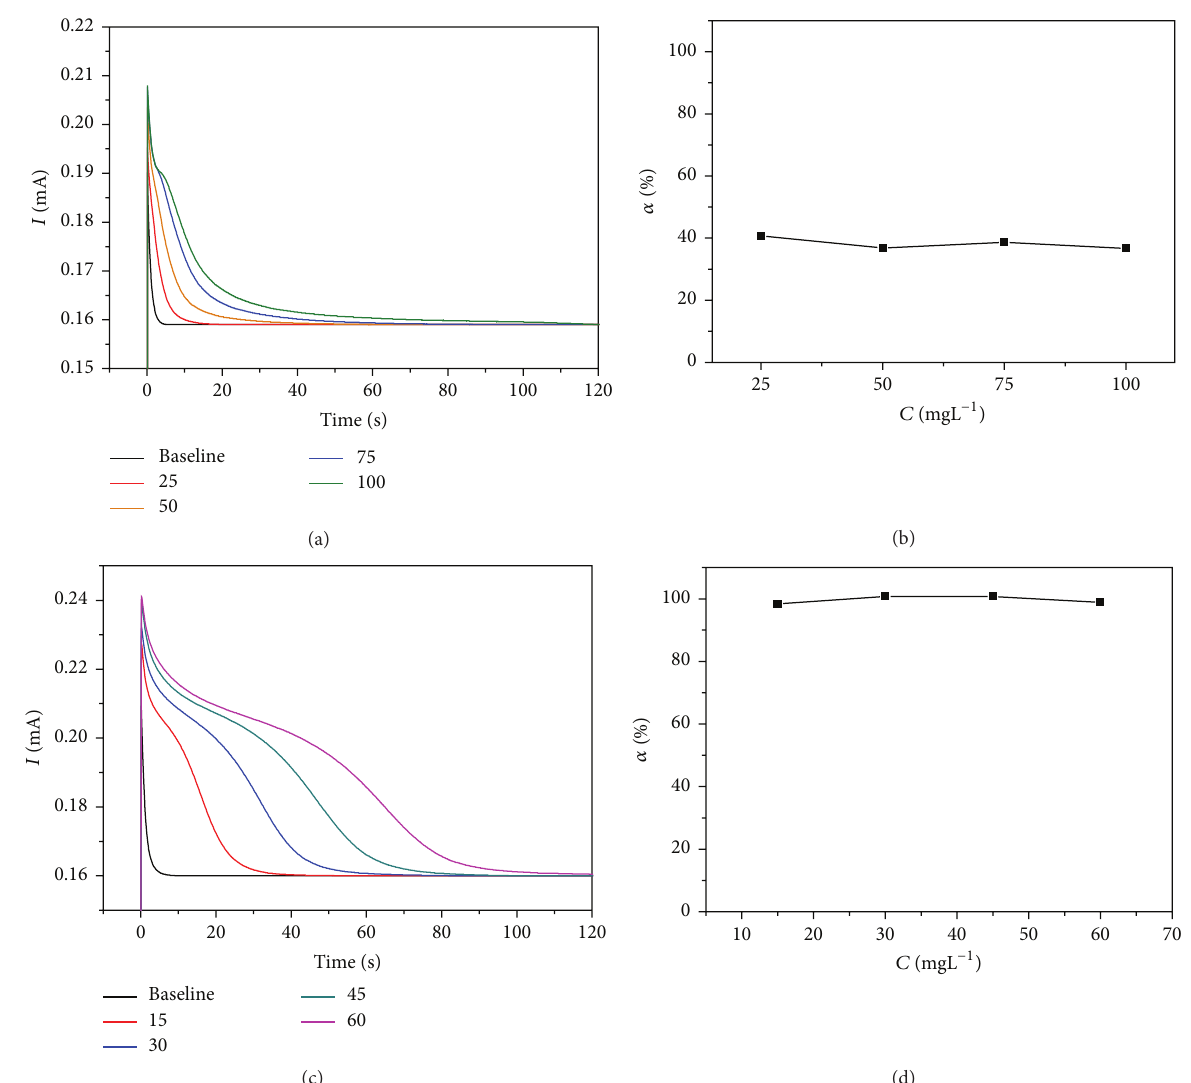
Figure 5: The photocurrent-time profiles and degradation rate ( 𝛼 ) of (a), (b) FA and (c), (d) MA.